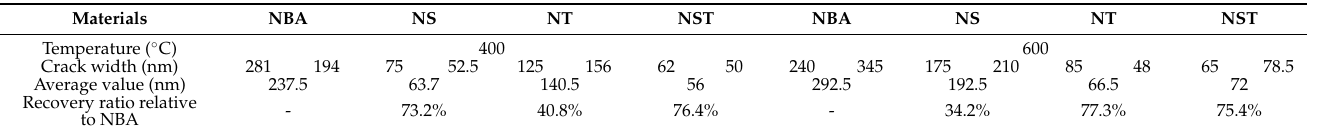
Table 4. Crack widths on the worn surfaces of NBA, NS, NT and NST and crack recovery ratio relative to NBA.